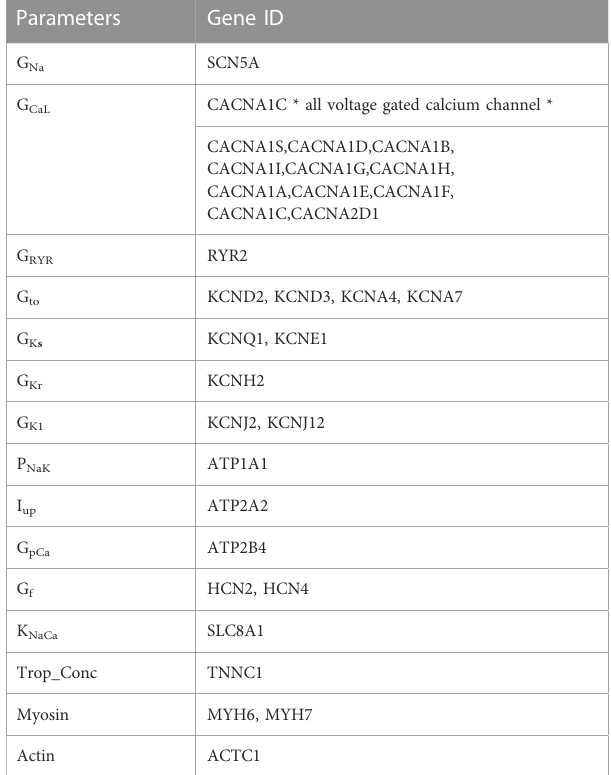
TABLE 2 Genes used to compute scaling factors for the 15 model